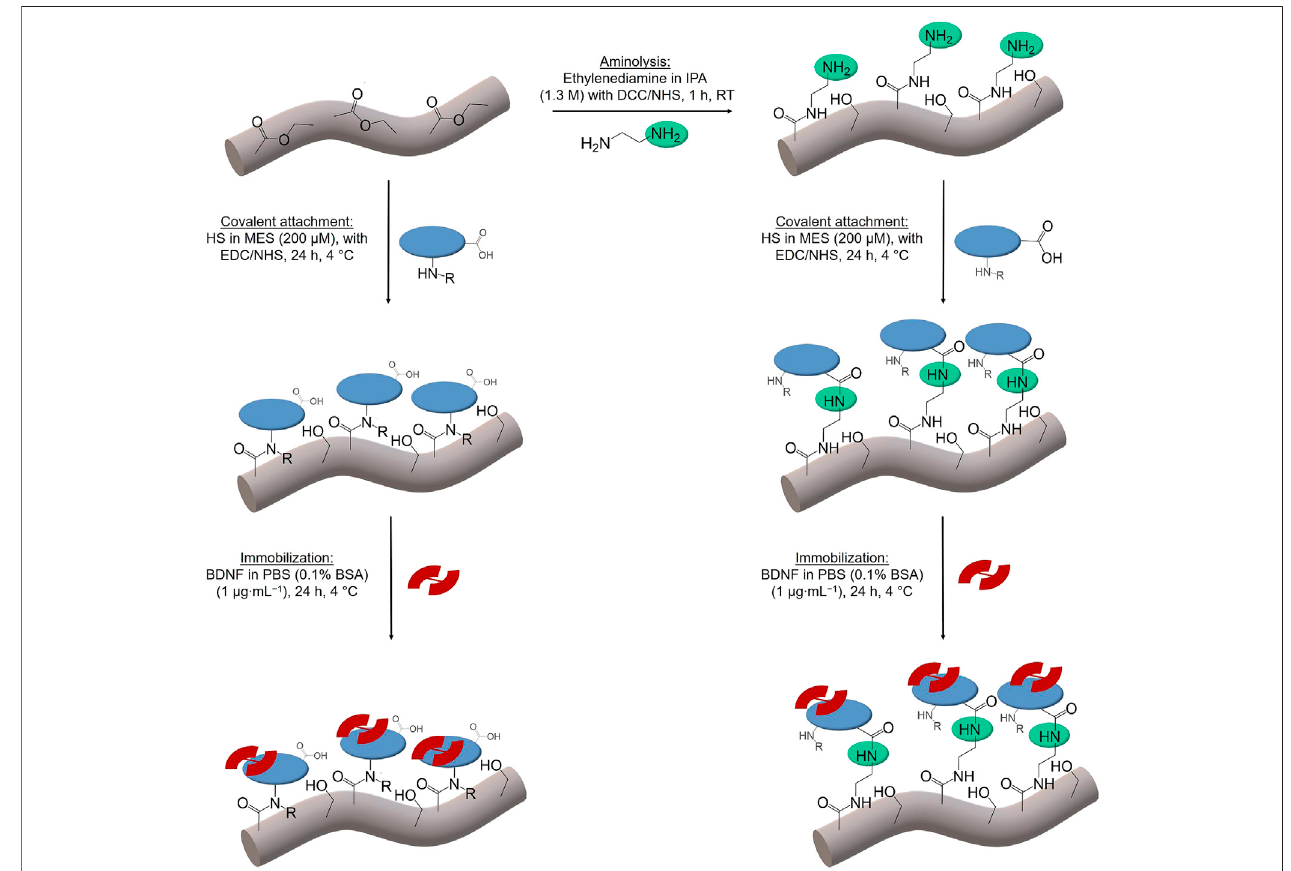
FIGURE 2 | Scheme of the chemical operations used in surface functionalization of PGA/PCL polymer fi bers (grey). Aminolysis with ethylenediamine (green); covalent attachment of HS (blue). Different functional groups of HS (amino (left)/carboxy (right)) lead to the coupling via amide bonds. The immobilization of BDNF (red) follows in both cases. IPA stands for isopropanol, DCC for N,N ′ -dicyclohexylcarbodiimide, NHS for N-hydroxysuccinimide, HS for heparan sulfate, MES for (2-N- morpholino)ethanesulfonic acid, EDC for1-ethyl-3-(3-dimethylaminopropyl)carbodiimide, BDNF for brain derived neurotrophic factor, PBS forphosphate buffered saline and BSA for bovine serum